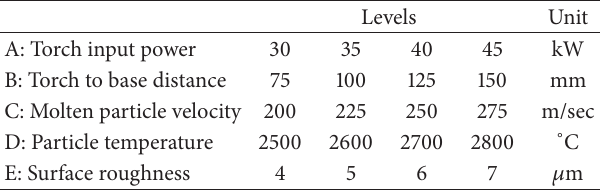
Table 2: Control factors with their selected levels. Levels